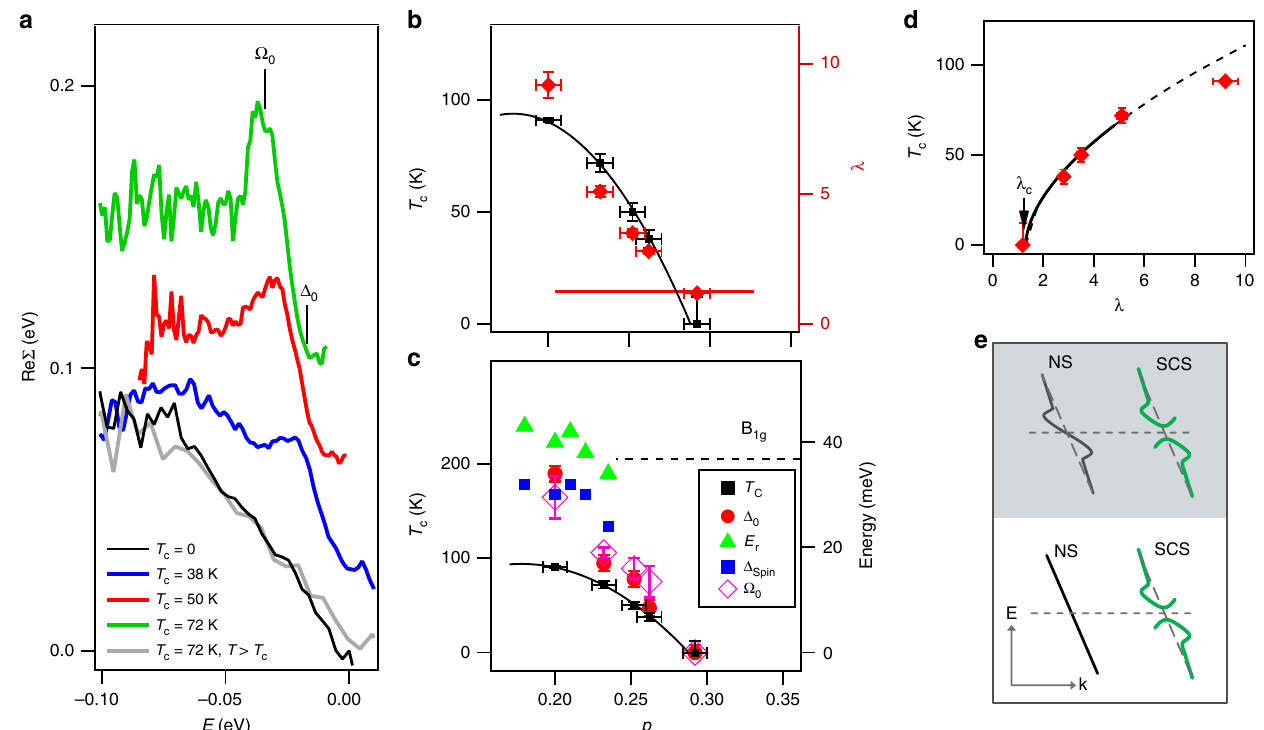
Fig. 3 Doping dependence of the antinodal renormalization effects. a Re Σ for four samples shown in Fig. 2. The curves are referenced to the Fermi level and those obtained in superconducting state are offset in y by 30 meV for clarity. b coupling strength λ , approximated as λ ¼ (cid:3) ∂ Re Σ ð ω Þ ∂ ω (cid:4) 1 : 3, is indicated by the red line. Corresponding T diamonds), plotted vs. doping. The normal state value, λ c energy, Ω 0 , as measured from the corresponding gap value (energy of the maximum in the state's dispersion) (magenta diamonds). Ω 0 of the as-grown sample is determined as described in the Methods section. Corresponding gap magnitude, Δ 0 (red circles) of the studied samples and antiferromagnetic resonance energy, E (green triangles), and spin gap, Δ (blue squares), from refs. 23 – 28 are also shown. The energy of B r Spin dashed line. T is referenced to the left-hand axis, while all the other quantities are referenced to the right-hand axis. d Dependence of T c coupling strength, λ , measured in the superconducting state. The solid curve represents the fi t to the power-law behavior, T overdoped samples. The dashed curve is the extrapolation from the fi tted region. The as-grown sample was not used in fi tting. e Schematic view of temperature development of the electronic dispersion upon transition from the normal state (NS) to superconducting state (SCS) in the conventional coupling scenario (top, shaded) and the actual one, observed in cuprate superconductors (bottom). The uncertainties in p , T Fig. 1a. The uncertainty in λ in b and d is the standard deviation of the slope obtained from the linear fi t of low-energy Re Σ . The uncertainty in Ω corresponds to the standard deviation of the peak position in Re Σ determined from fi tting, except for the as-grown sample (see the Methods